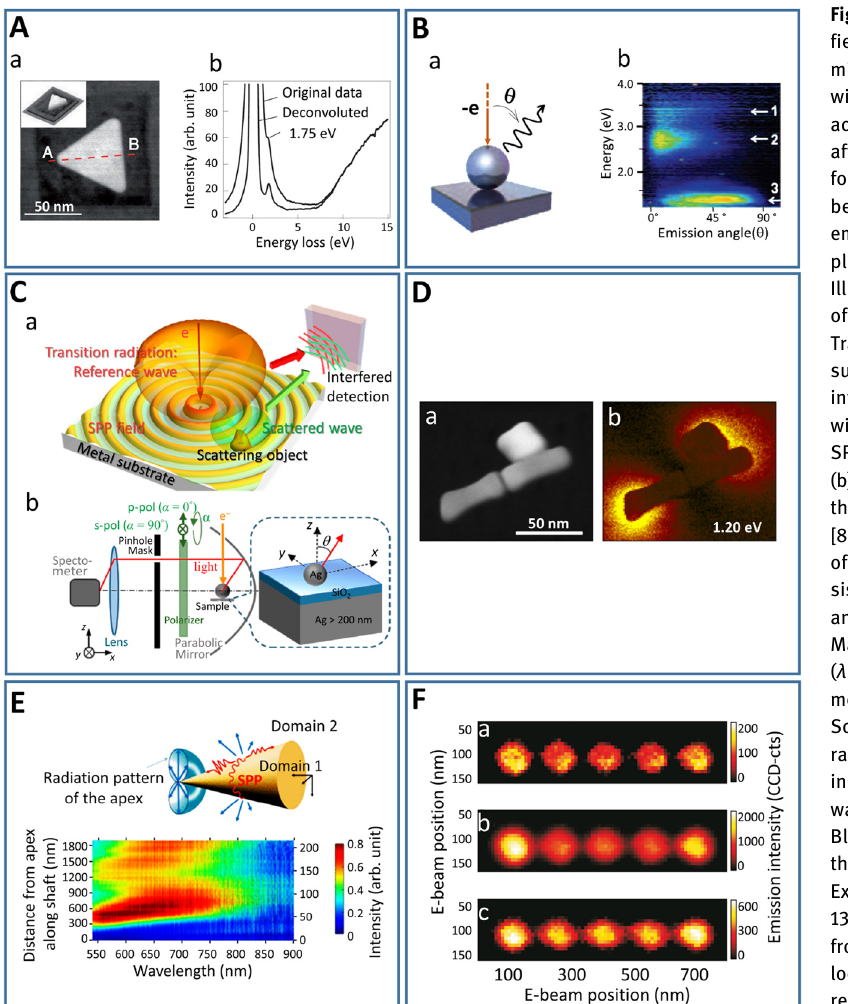
Figure 5: (A) (a) High-angle annular dark- field scanning transmission